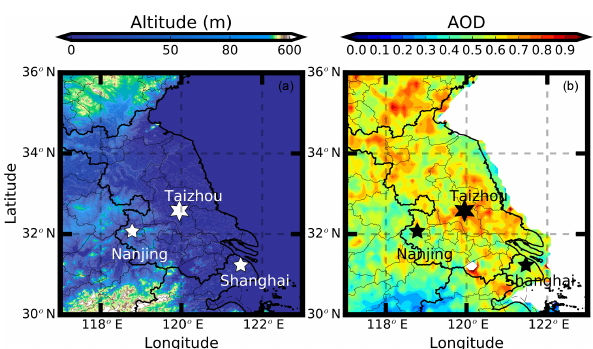
Figure 1. Measurement site of Taizhou (marked with stars). Filled colors represent (a) the topography of the Jianghuai Plain. (b) The average aerosol optical depth at 550nm during the year 2017 from the Moderate Resolution Imaging Spectroradiometer onboard the satellite